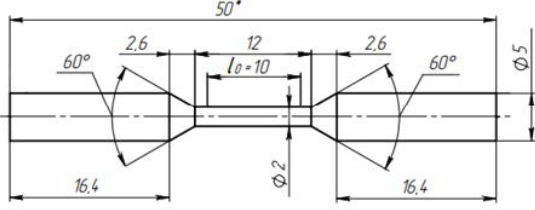
Table 1. Chemical composition of Grade 4 (wt.%).